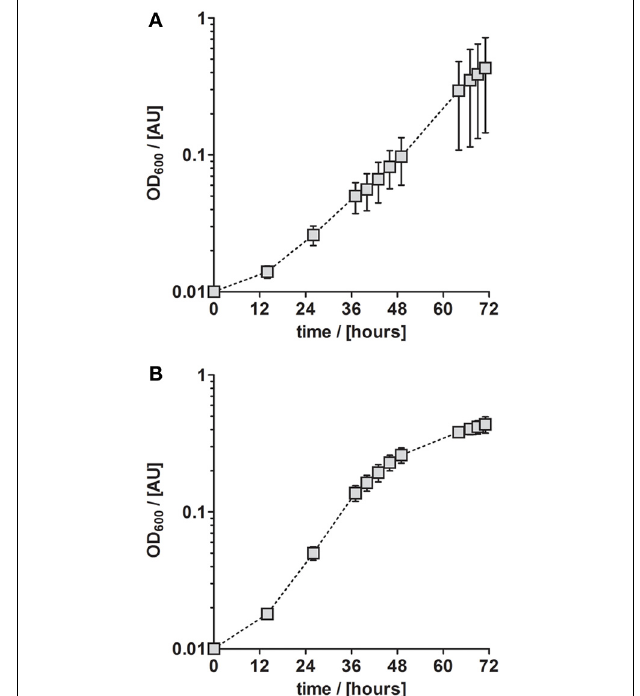
FIGURE 1 | Anaerobic growth of P. denitrificans Pd1222 on published media. Growth was performed on two media previously described for P. denitrificans or P. pantotropha with trace element concentrations as given in Table 1 . (A) Growth with chelated trace element solution TE-1 after Robertson and Kuenen (1983). (B) Growth with acidic trace element solution TE-2 after Strohm et al. (2007). The graphs represent three replicates; error bars indicate standard deviation and may be smaller than the